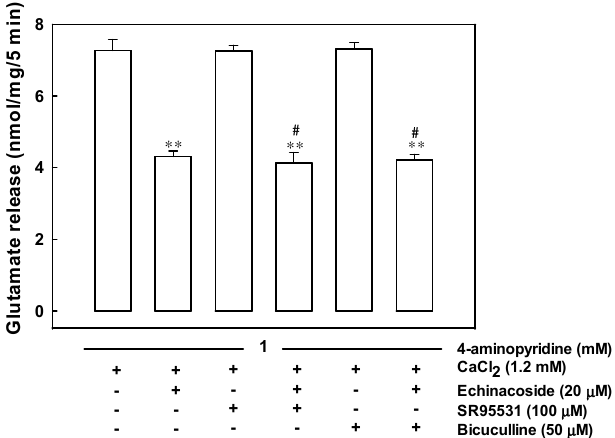
Figure 5. Effect of the gamma-Aminobutyric acid A (GABA A ) receptor antagonists SR95531 and bicuculline on the echinacoside-mediated inhibition of glutamate release. Glutamate release was evoked by 1 mM 4-aminopyridine in the absence (control) or in the presence of 20 µM echinacoside, 100 µM SR95531, 100 µM SR95531 and 20 µM echinacoside, 50 µM bicuculline, or 50 µM bicuculline and 20 µM echinacoside. Results are mean ± S.E.M. of 5 independent synaptosomal preparations. **, p < 0.001 versus control group. #, p < 0.05 versus the SR95531-, or bicuculline-treated group.